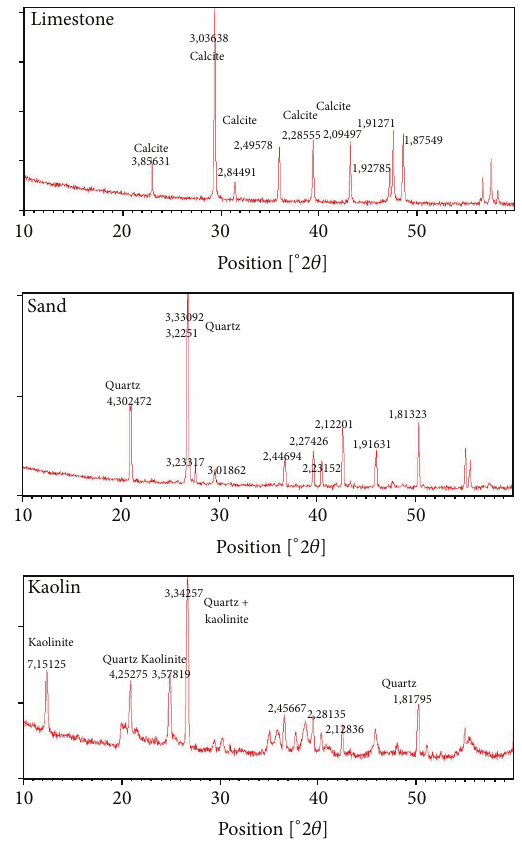
Figure 1: XRD of the samples of raw materials.